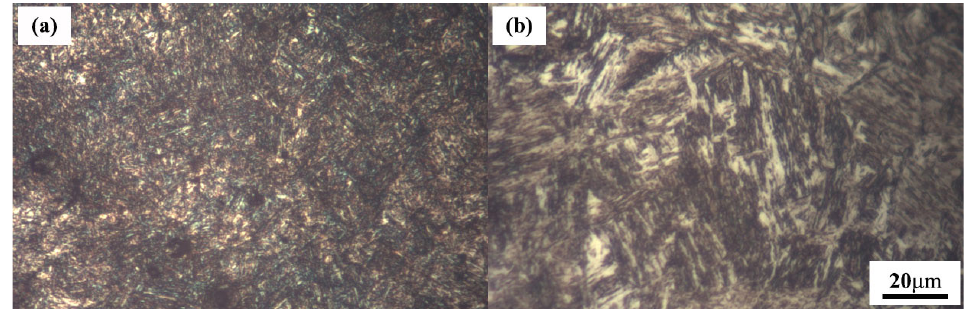
Figure 8. Microstructure of phases in quenching crack resistance specimens after quenching in (a) regular tap water, and (b) magnetically treated tap